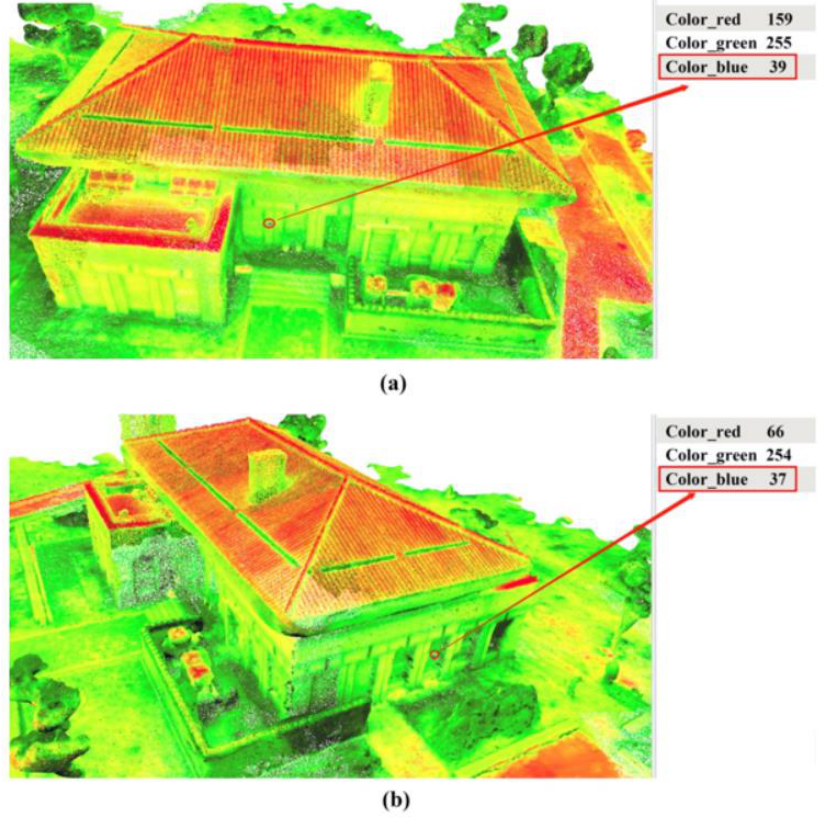
Figure 19. Images of ( a ) west in the 3D TIR model, ( b ) south in the 3D TIR